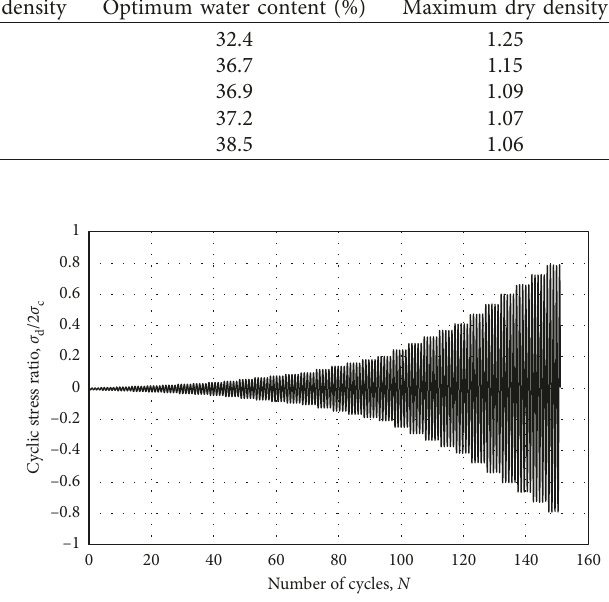
Figure 3: Typical cyclic loading pattern used in the